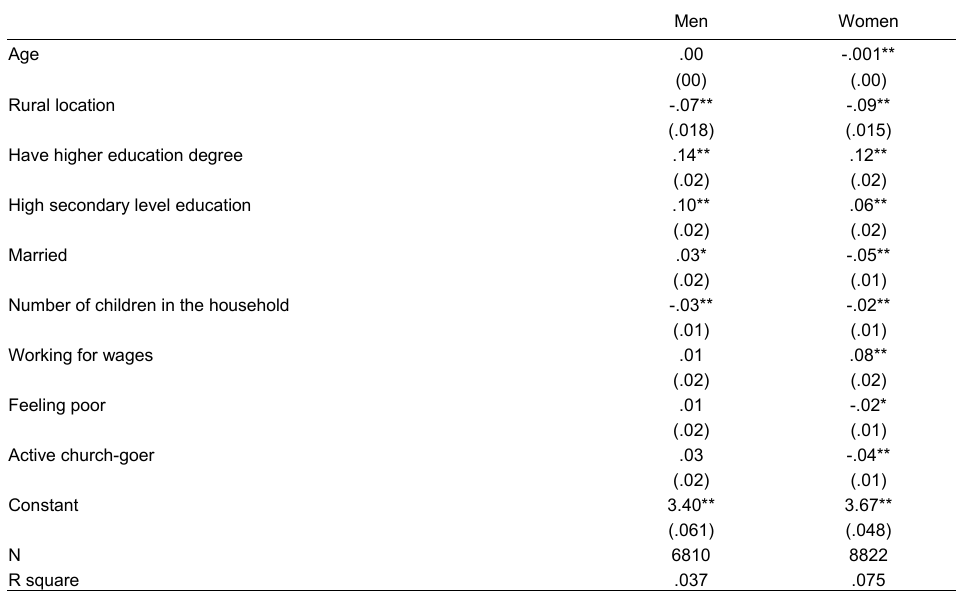
Table 4. Linear regression coefficients and standard errors predicting liberal gender role opinions, for men and women